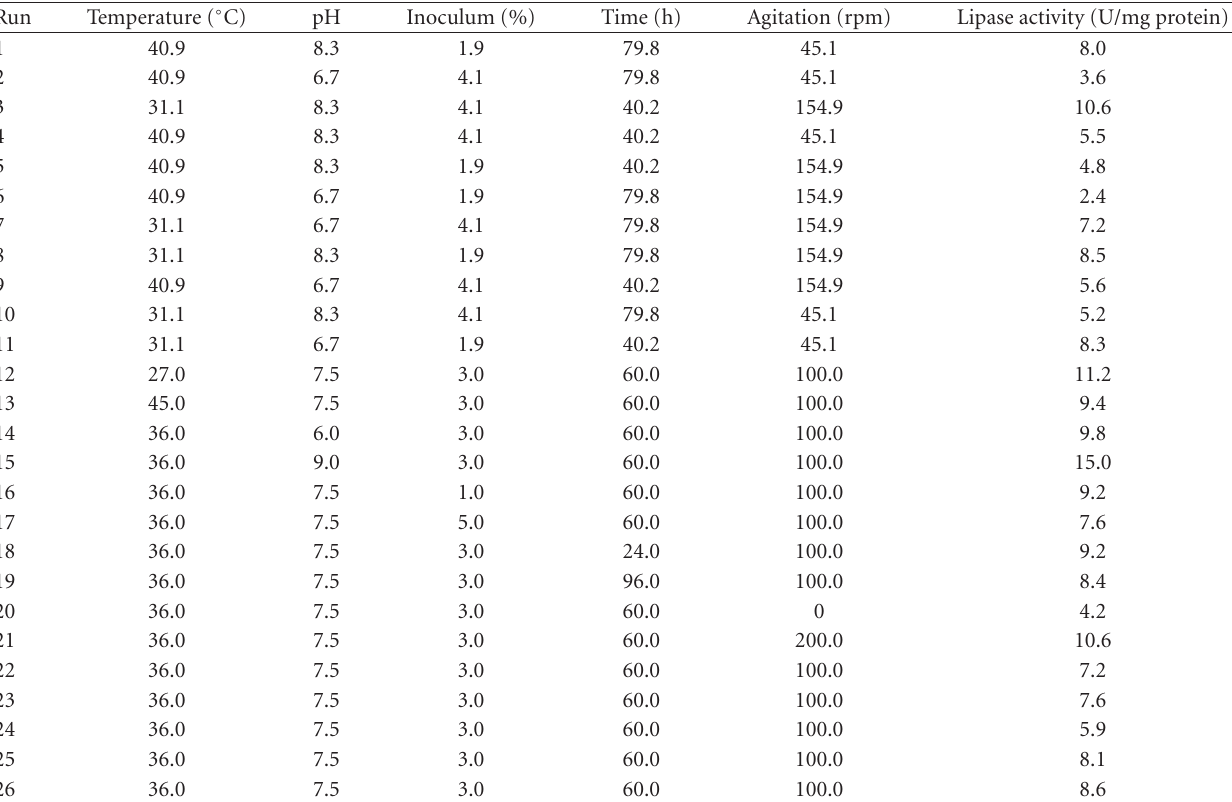
Table 1: Experimental design used in ANN studies by using five independent variables showing observed values of lipase activity in